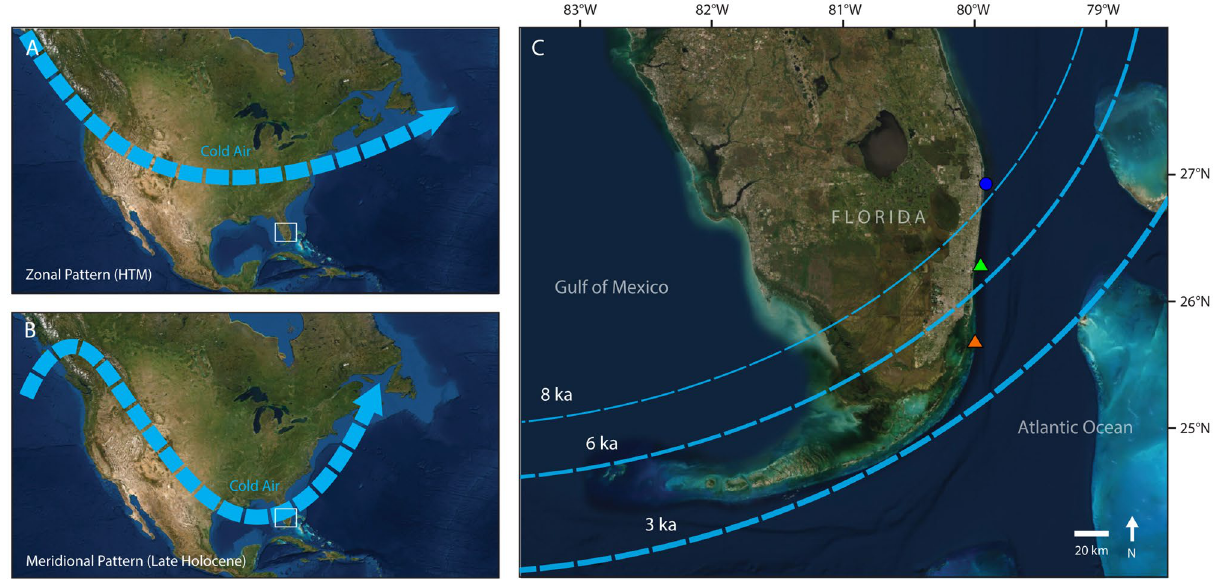
Figure 5. Diagram of the two dominant patterns of winter atmospheric circulation over North America in relation to our study area: (a) dominance of zonal flow, which suppresses the transport of cold air to the southeastern United States and (b) dominance of meridional flow, which is associated with increased frequency of winter cold fronts reaching the southern United States including to southern Florida (bounding box) 26 . Southern Florida is expanded in (c) , which shows the approximate trajectory (~ 45° angle) of winter cold fronts in this region 91 in relation to our sampling locations on the Palm Beach Outer Reef (blue circle), the Broward Inner Reef (green triangle), and the Miami Inner Reef (orange triangle). This panel provides a hypothetical conceptual model (dashed lines) of when extreme winter cold fronts would reach different latitudes in southeast Florida with high enough frequency to suppress reef development. We suggest that extreme winter weather would have impacted increasingly southern latitudes over the Holocene in response to climate forcing. Cold front intensity may have also increased over time, a trend represented by the thickness of the dashed lines. Map image is the intellectual property of Esri and is used herein under license. Copyright 2020 Esri and its licensors. All rights